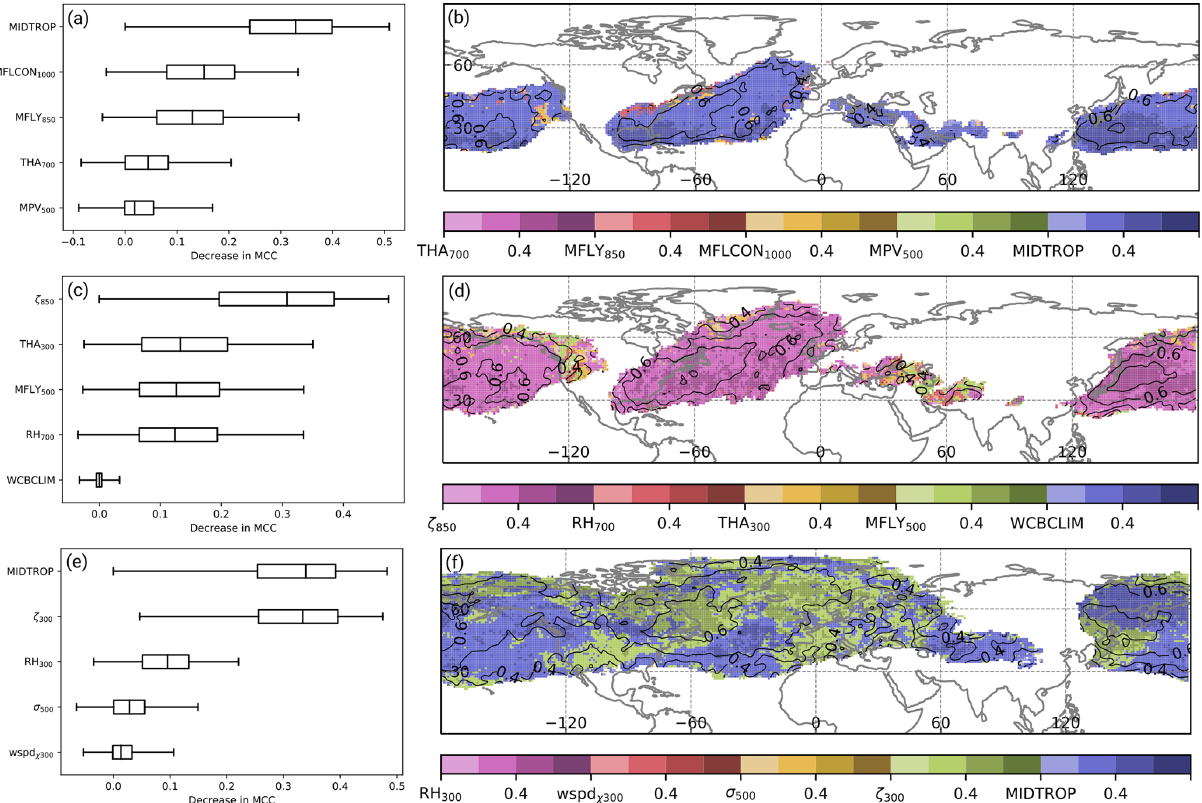
Figure 7. Feature importance scores in terms of the reduction in MCC for (a, b) WCB inflow, (c, d) WCB ascent, and (e, f) WCB outflow. Box-and-whisker plots in (a, c, e) show the median (vertical line), interquartile range (boxes), and the 5th and 95th percentiles of the decrease in MCC over all grid points at which the climatological occurrence frequency reaches at least 1%. Shading in (b, d, f) shows the decrease in MCC when perturbing the most important predictor. The darker the shading (at intervals of 0.2), the greater the decrease in the MCC. Black contours indicate the MCC of the reference prediction at intervals of